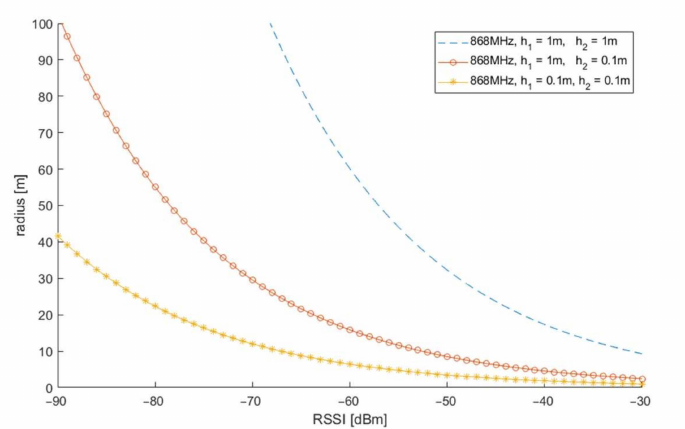
Figure 2. Dependence of the distance between radio sensors on RSSI (received signal strength indicator) for different antenna heights (h 1 and h 2